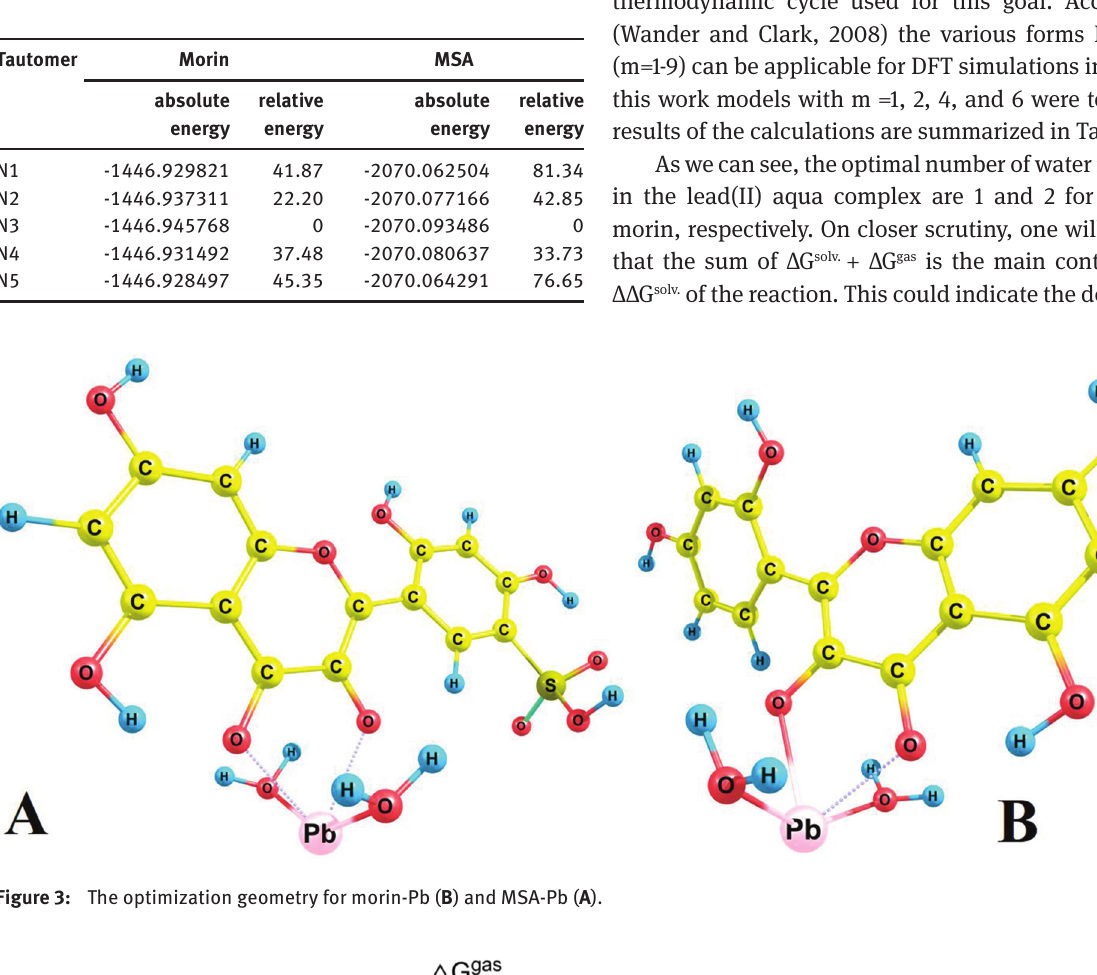
Table 2 : The absolute (a.u.) and relative (kJ·mol -1 ) energies for Pb 2+ - morin/MSA